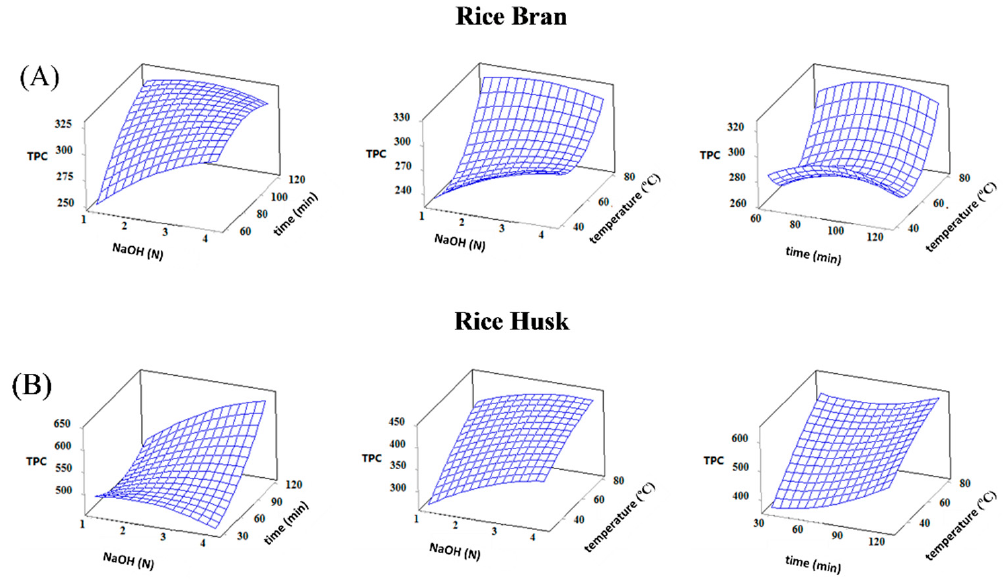
Figure 2. Effect of NaOH concentration, time and temperature hydrolysis on total phenolic content (TPC, mg GAE/100 g) of bound phenolics from ( A ) rice bran and ( B ) rice husk fractions.